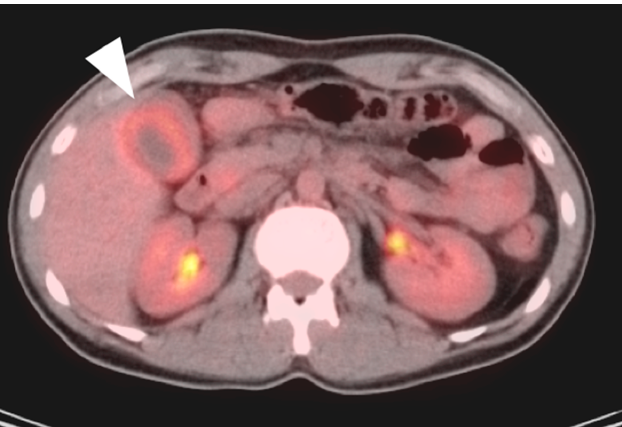
Figure 22. An axial fused FDG PET-CT image shows gallbladder wall thickening and diffuse increased metabolic activity within the liver consistent with cholecystitis, either infectious or inflammatory (white arrowhead). There is slight mis-registration between the CT and PET due to differences in breathing between the two exams.